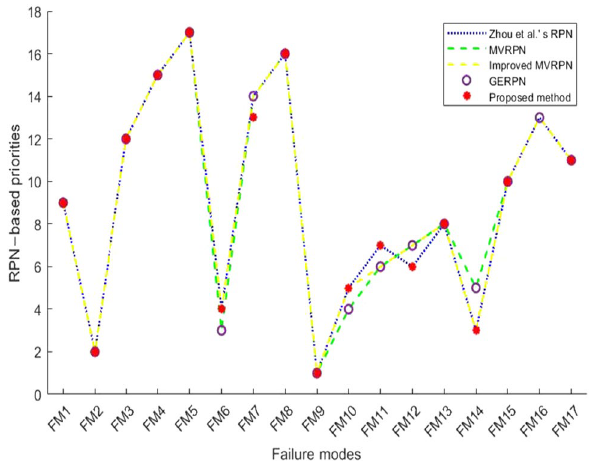
Figure 4. Ranking of failure modes with different methods.